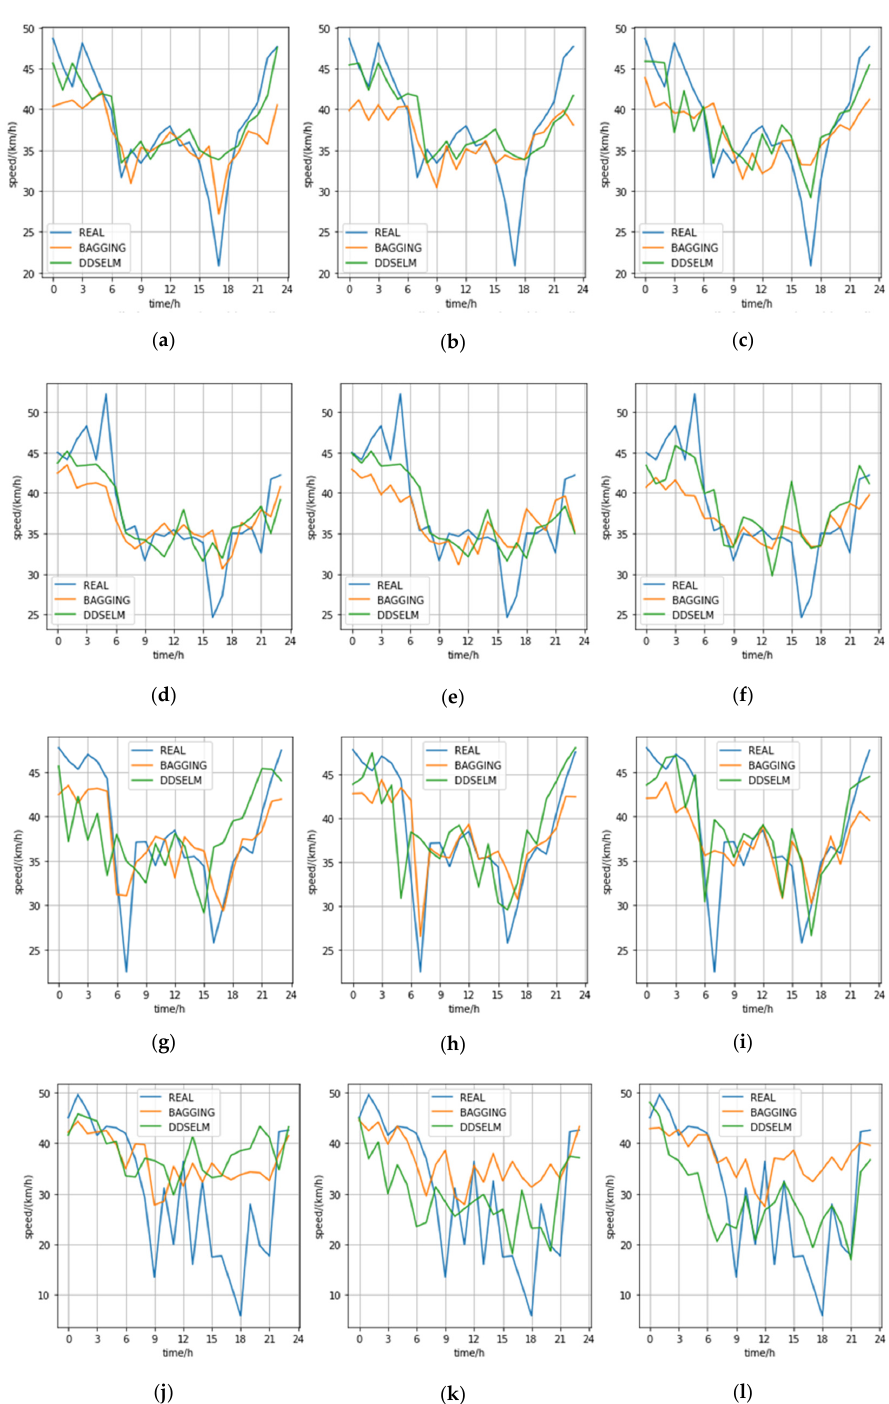
Figure 5. The prediction comparisons by two ensemble methods on Wednesday and Saturday:( a ) one-step-ahead prediction result on Wednesday in northbound; ( b ) two-step-ahead prediction result on Wednesday in northbound; ( c ) three-step-ahead prediction result on Wednesday in northbound; ( d ) one-step-ahead prediction result on Saturday in northbound; ( e ) two-step-ahead prediction result on Saturday in northbound; ( f ) three-step-ahead prediction result on Saturday in northbound; ( g ) one-step-ahead prediction result on Wednesday in southbound; ( h ) two-step-ahead prediction result on Wednesday in southbound; ( i ) three-step-ahead prediction result on Wednesday in southbound; ( j ) one-step-ahead prediction result on Saturday in southbound; ( k ) two-step-ahead prediction result on Saturday in southbound; ( l ) three-step-ahead prediction result on Saturday in